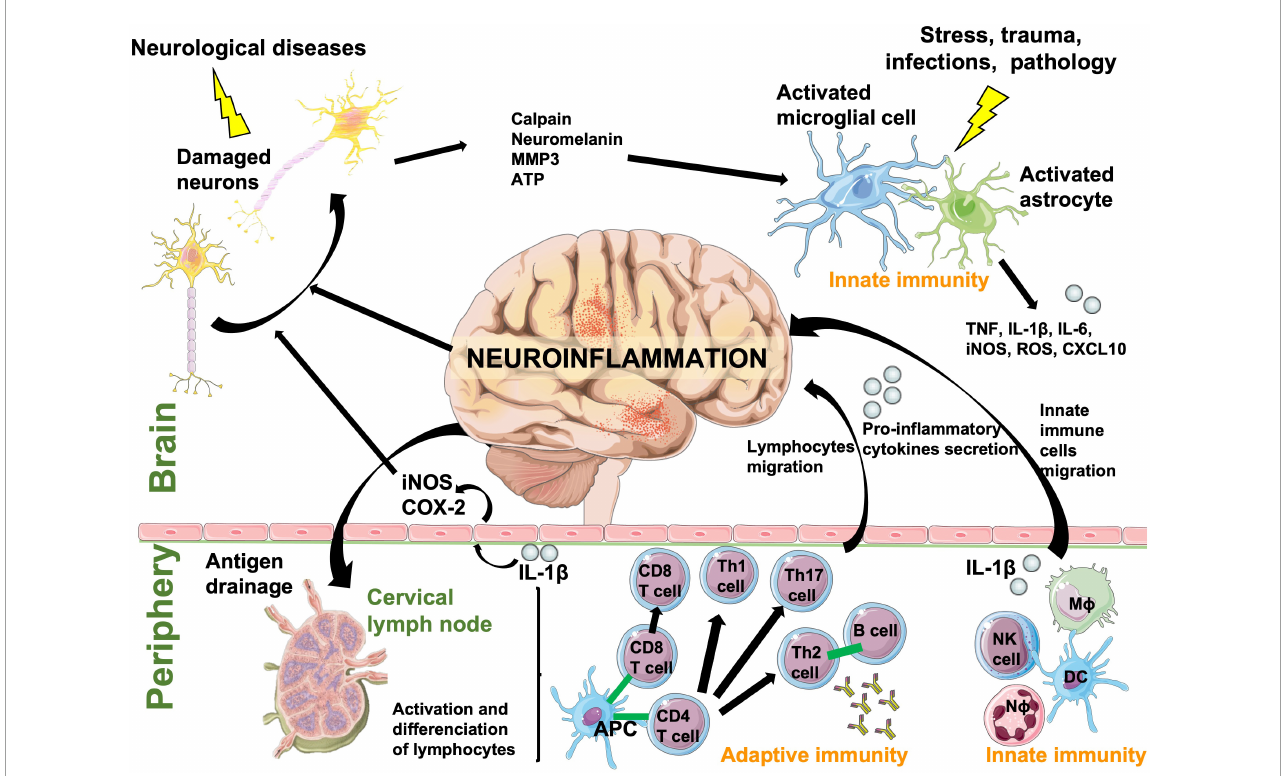
FIGURE2 A schematic diagram showing the bidirectional communication between central and systemic immune system responses that cause neuroinflammation. Resident immune cells in the brain, microglia and astrocytes, act as scavengers to rapidly react to a pathological event. Immune cells in the periphery communicate with microglia and astrocytes through cytokines and chemokines. Foreign/pathological substances or antigens are drained from the CNS to peripheral lymph nodes where they are processed and presented to adaptive cells by antigen presenting cells. Peripheral innate and adaptive cells react to these signals and antigen presentation and cross the blood brain barrier to help eliminate the pathological event. They are also responsible of neuronal damage by inducing neuroinflammation. APC, antigen-presenting cell; ATP, adenosine triphosphate; CD4 T cell, lymphocyte T helper expressing CD4 (cluster of differentiation 4) glycoprotein; CD8 T cell, cytotoxic T cell expressing CD8; COX-2, cyclooxygenase-2; CXCL10, C-X-C motif chemokine ligand 10; DC, dendritic cell; IL, interleukin; iNOS, inducible nitric oxide synthase; M φ , macrophage; MMP3, matrix metalloproteinase-3; N φ , neutrophil; NK, natural killer; Th cell, lymphocyte T helper; TNF, tumor necrosis